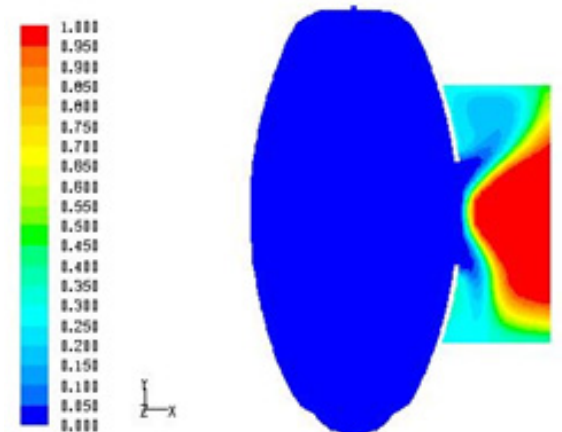
Fig. 3-7. At a higher water level, the expressive rotating flow is persisting, the conical water spray partially hits on the inner wall of the flange and is coming back. The gravity influence is less, but still evident it is the some flow along the bottom wall of the flange.